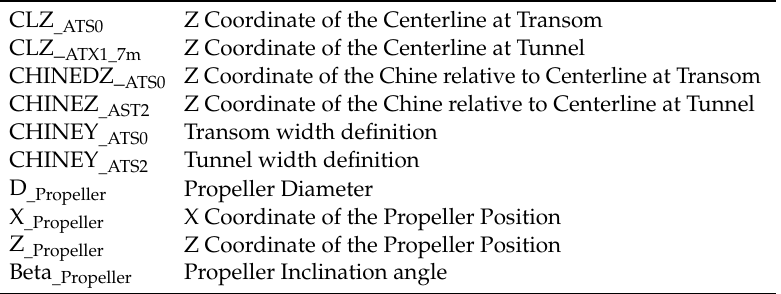
Table 4. Local optimization variables.